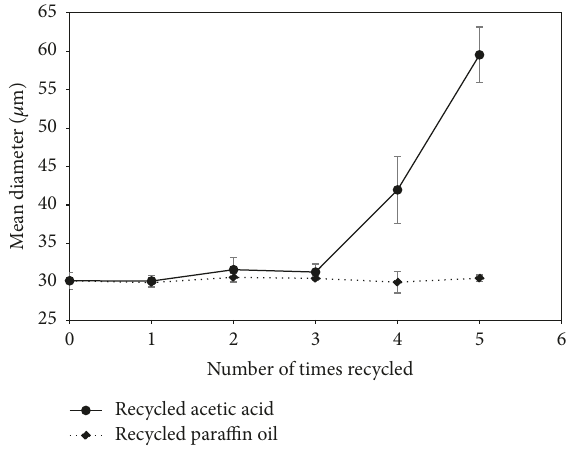
Figure 1: Effect of recycled paraffin oil and acetic acid on the mean diameter of 𝜇 CBs (3% w/v cellulose solution; 3% w/v Span 80; stirring speed 1000rpm; 30 ∘